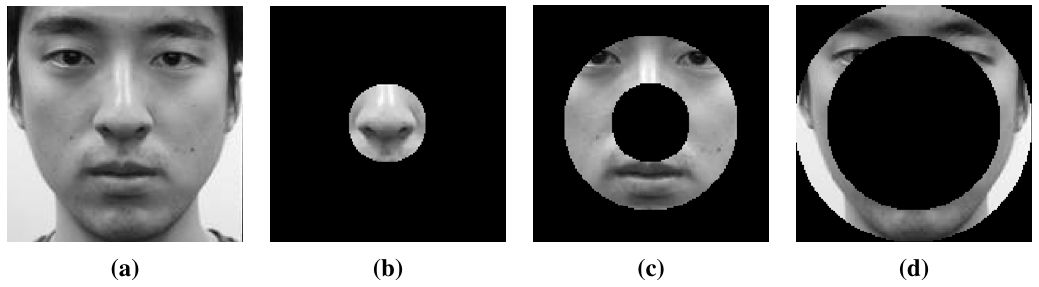
Figure 12. Subregions before extracting the power histogram (( a ) original image, ( b ) Subregion 1 (subR1), ( c ) subR2 and ( d )